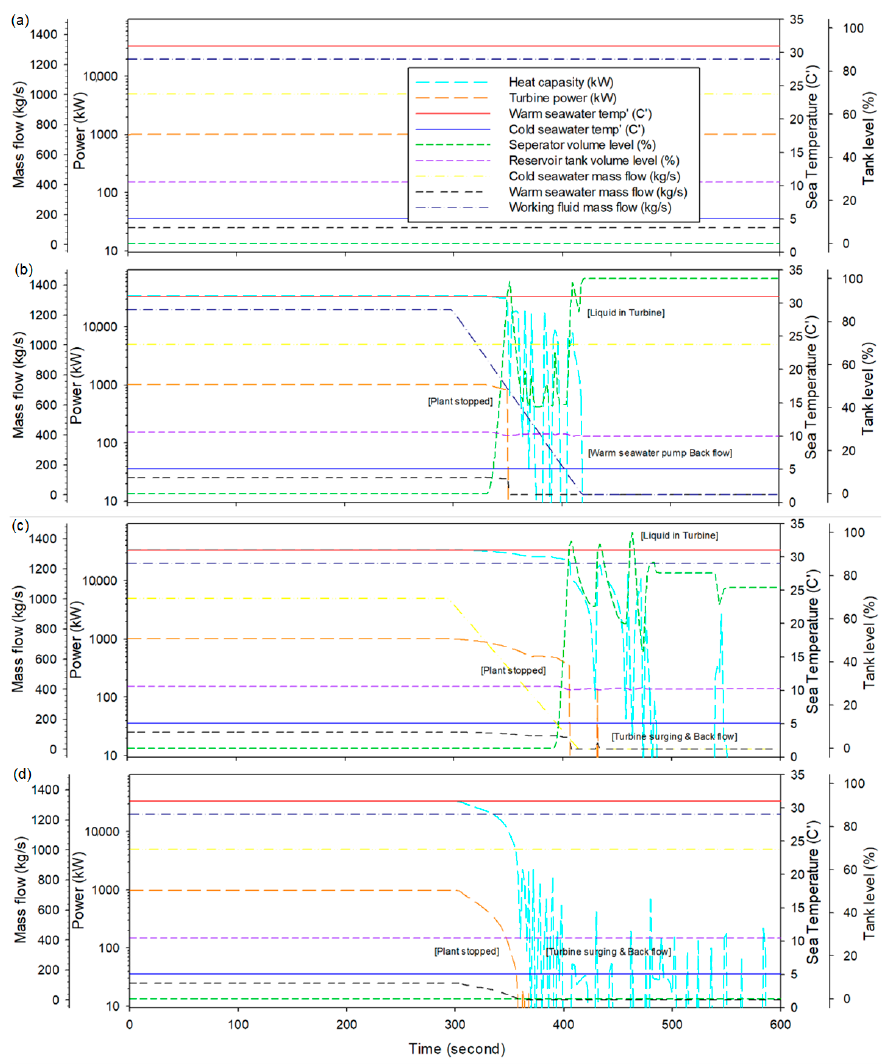
Figure 5. Operating condition of ( a ) standard conditions, ( b ) surface seawater pump shutdown, ( c ) deep seawater pump shutdown, and ( d ) refrigerant pump shutdown.